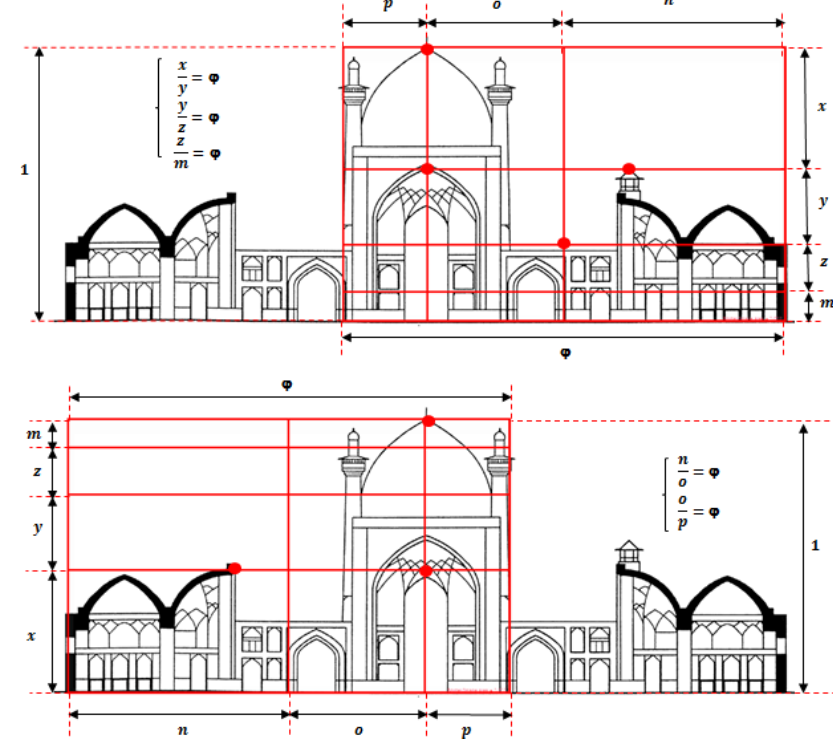
Figure 14: Comparing between two similar abstract